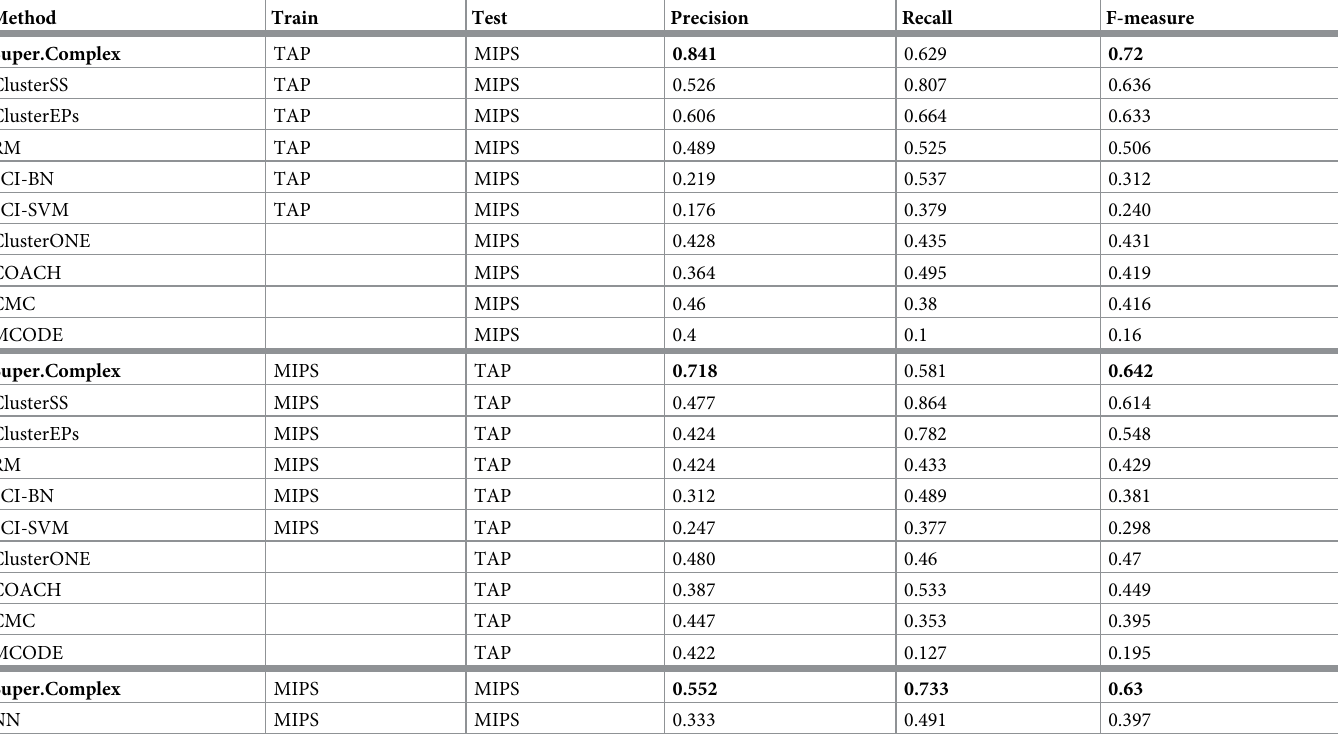
Table 3. Comparing our method with 6 supervised and 4 unsupervised methods on a yeast PPI network. Method Train Test